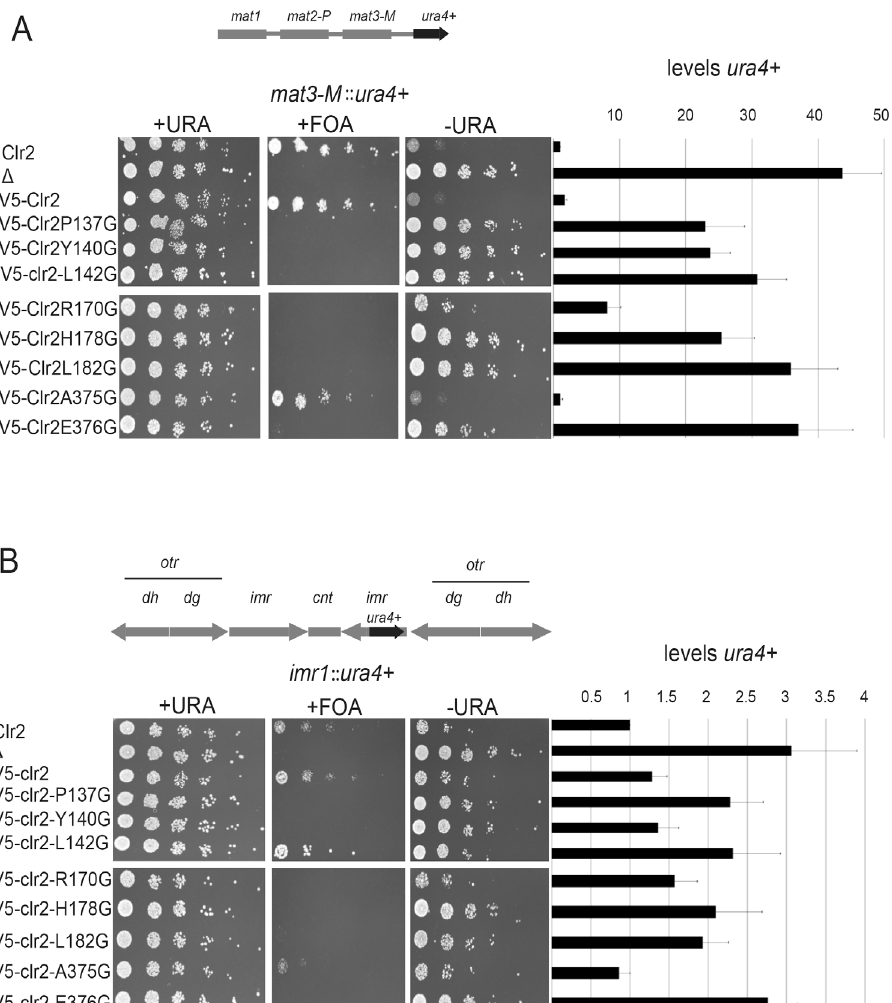
Figure 2. Point mutations in Clr2 resulted in derepression of reporter genes in the mating type and pericentromeric regions. Cells were serially diluted in steps of five and 5 m l were spotted onto selective media. Media used were ( + URA), counter-selective (FOA) and selective (- URA) plates. The amount of ura4 + transcript was quantified using RT-qPCR and the wild type expression was set to 1. Top lane is the wild type strain (Clr2) that grew poorly on the selective plates. Second lane is a strain lacking Clr2 ( D ), third contains the V5-Clr2 followed by strains expressing mutated versions of the Clr2 protein: V5-Clr2P137G, V5-Clr2Y140G, V5-Clr2L142G, V5-Clr2R170G, V5-Clr2H178G, V5-Clr2L182G, V5-Clr2A375G and V5- Clr2E376G. (A) The spotted strain carries the mat3-M::ura4 + reporter in the mating type region. (B) The strains have the pericentromeric reporter gene imr ( Nco I) ::ura4 + .